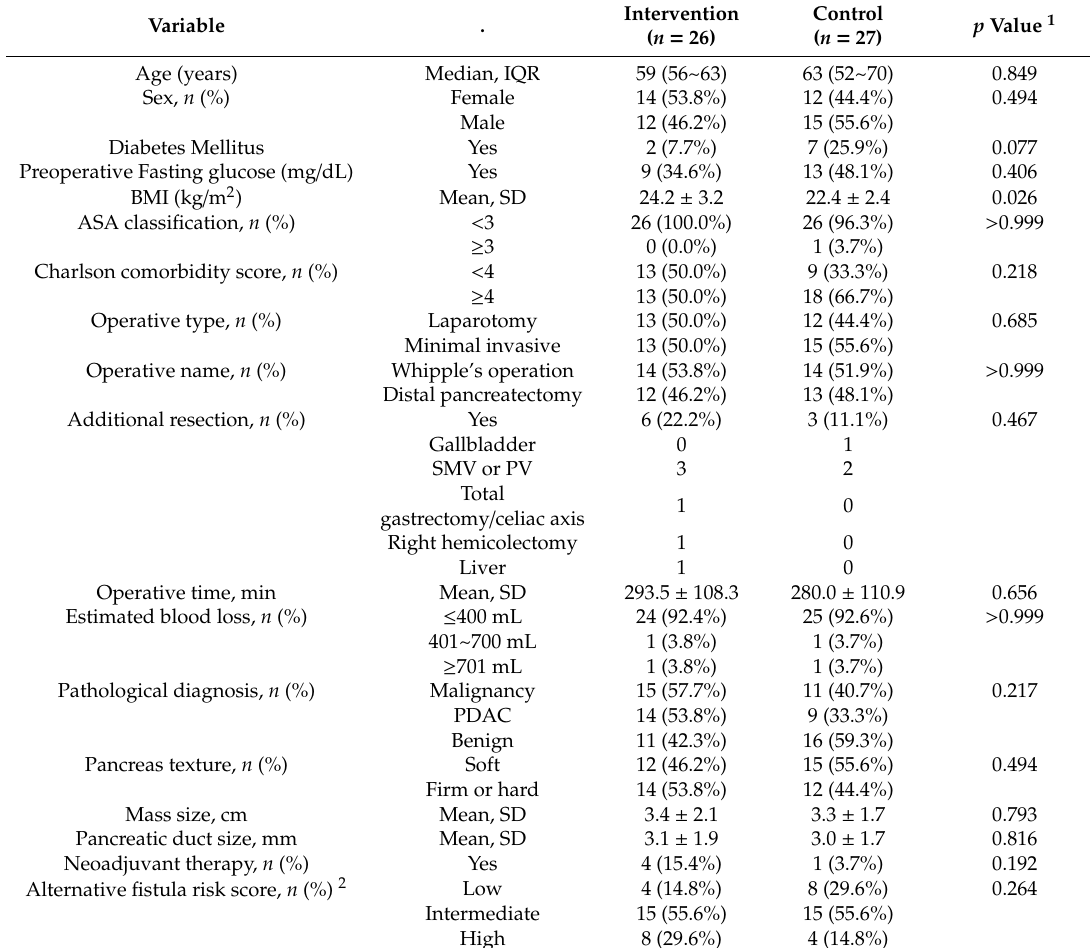
Table 1. Clinicopathological features of patients who underwent